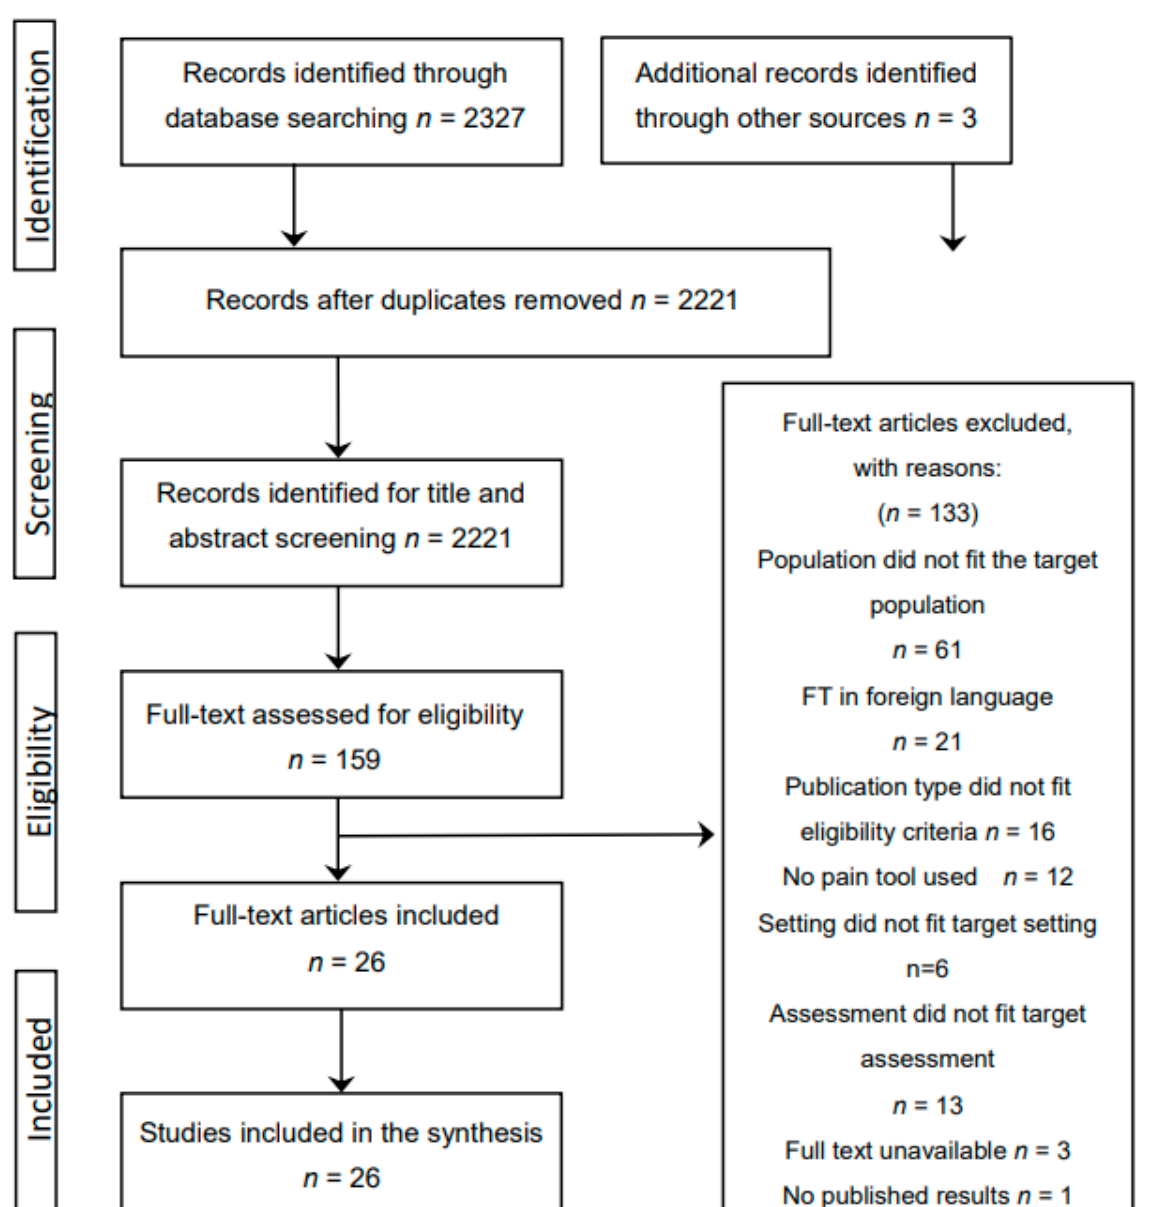
Figure 1. Search strategy using the PRISMA flowchart.